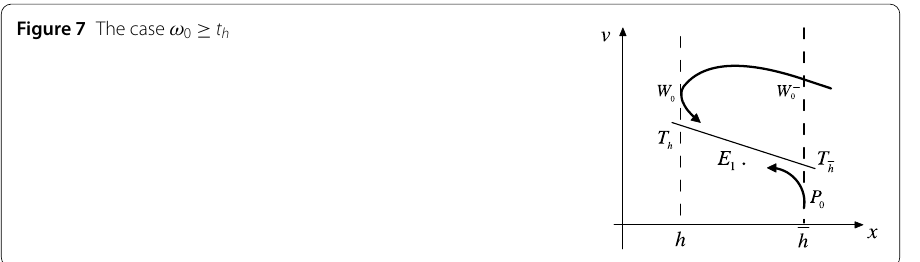
Figure 7 The case ω 0 ≥ t